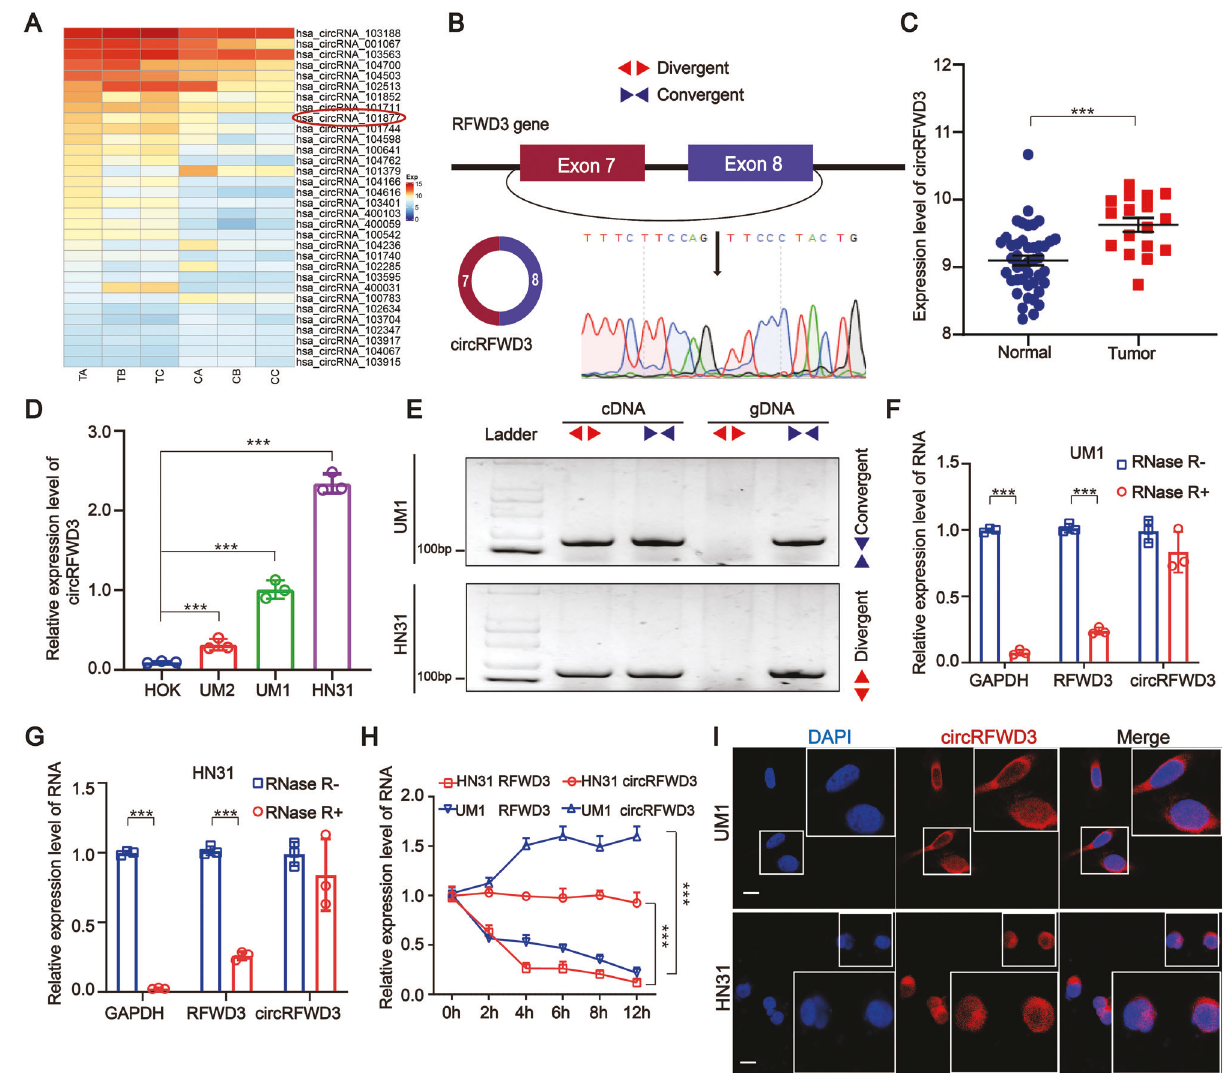
Fig. 1 Screen and characterization of circRFWD3 in HNSCC. A Clustered heatmap showing the 32 differentially expressed circRNAs in three groups of human HNSCC tissues and adjacent normal tissues (red indicates upregulated circRNAs, and blue indicates downregulated circRNAs). The rows represent groups of HNSCC tissue samples (C, normal tissue; T, tumor tissue), and columns represent circRNAs ’ numerical ID obtained from circBase. B The genomic loci of the RFWD3 gene and circRFWD3 were primarily transcribed from exons 7 and 8 of RFWD3, which were detected by qRT-PCR and validated by Sanger sequencing ampli fi ed with divergent primers. C , D The expression level of circRFWD3 in 43 normal tissues and 17 HNSCC tissues (data from TCGA) and in normal HOK cells and three HNSCC cell lines. E Agarose gel electrophoresis with RT-PCR products using divergent and convergent primers in both gDNA and cDNA. Red arrows showed that divergent primers could amplify circRFWD3 from cDNA. F , G qRT-PCR was used to determine the abundance of circRFWD3 and linear RFWD3 mRNA in UM1 and HN31 cells treated with RNase R. Results demonstrated circRFWD3 was tolerant to RNase R. H CirRFWD3 resistance to actinomycin D (ActD) was detected by the qRT-PCR assay. I RNA FISH showed that circRFWD3 located in the cytoplasm in UM1 and HN31 cells, scale bars, 10 μ m. Data were shown as the mean value ± SD of three independent experiments. The asterisks indicate signi fi cant differences (Student ’ s t -tests, * P < 0.05, ** P < 0.01, *** P < RESULTS CircRFWD3 is overexpressed in HNSCC tissues and cell lines Nine pairs of HNSCC tissues were divided into groups of three and paired adjacent nontumor tissues were also divided into corresponding groups of three. Then a circRNA microarray was performed to identity signi fi cantly expressed circRNAs in HNSCC. After screening, we obtained 32 circRNAs, including 23 upregulated and nine downregulated circRNAs (Fig. 1A). Among those signi fi cantly upregulated circRNAs, circRFWD3 (also called